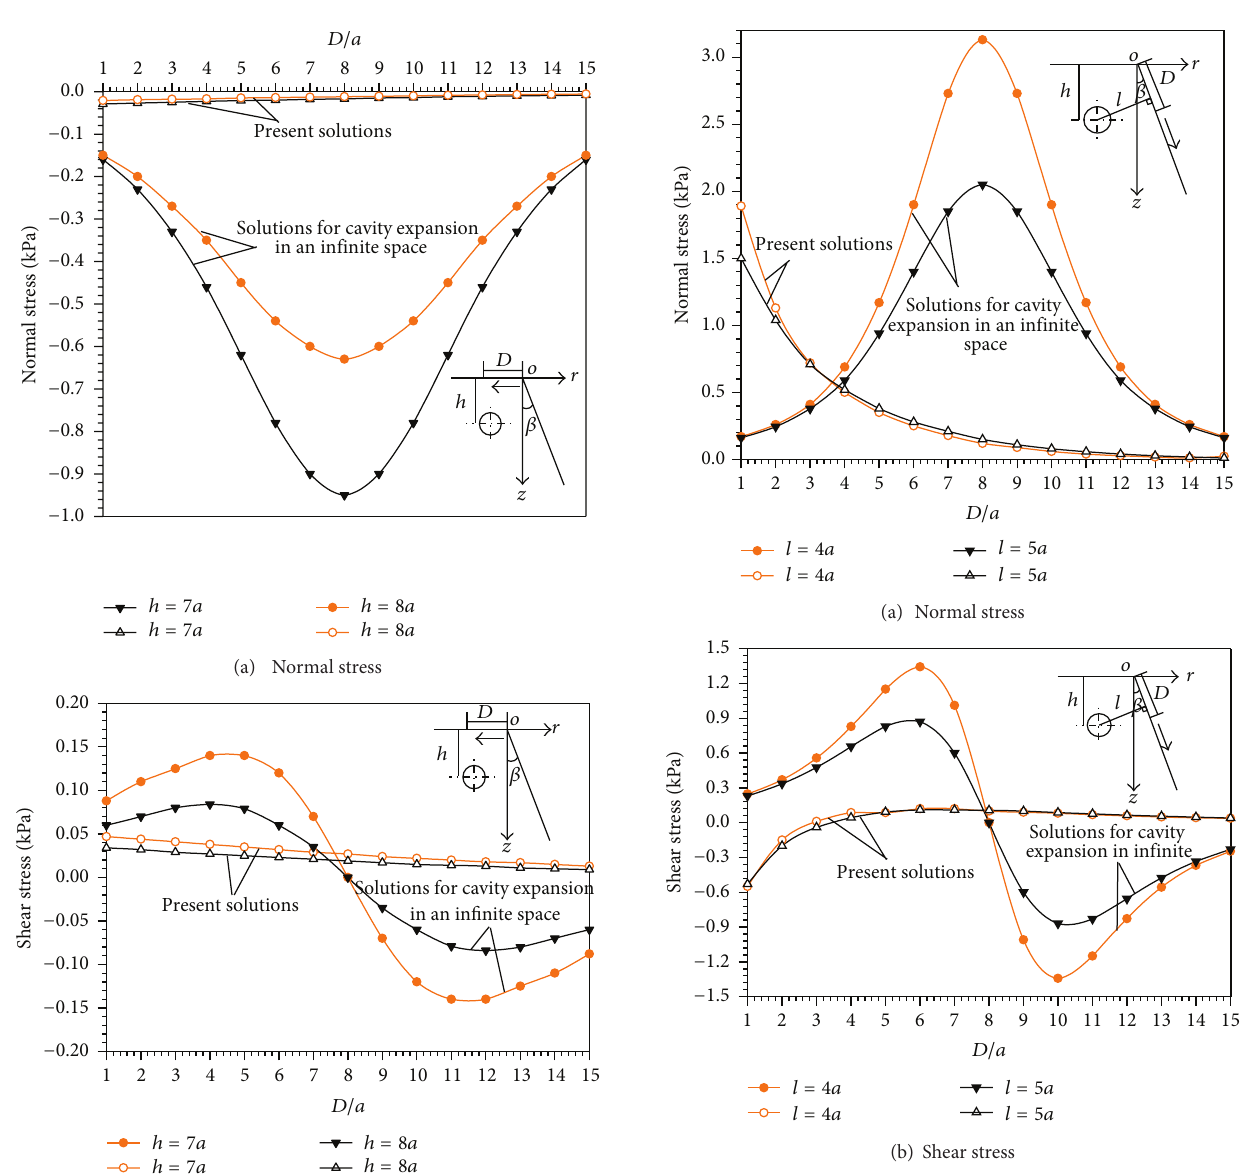
Figure 9: Stress along the sloping free